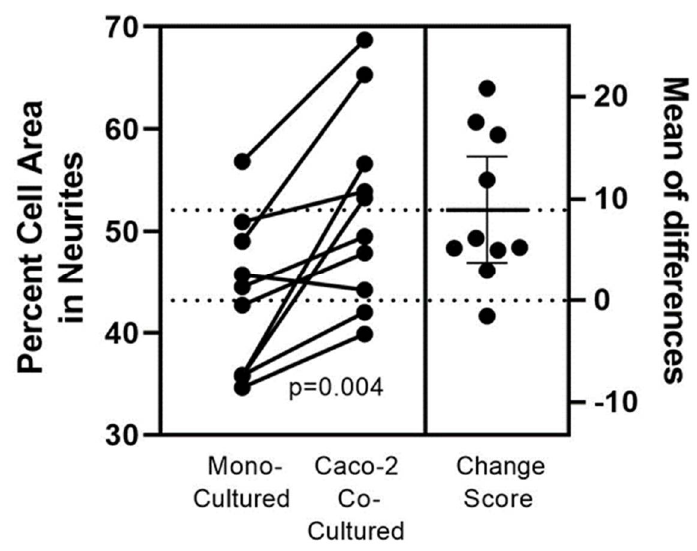
Figure 2. Quantifying the Caco2Bbe1 effect on neurite out-growth in SH-SY5Y cells directly co-cultured. Caco2Bbe1 (Caco-2) cells were plated at n = 200,000/well in 3 mL 6-well plates with complete 10% FBS media, incubated, and refed on day 6. On day 7 a single swipe was made in the middle of each well using flat end of a sterile p1000 pipette tip. Debris was removed and a fresh suspension of n = 2000 SH-SY5Y cells was added to each well along with fresh complete media (3 mL per well). Paired controls were set-up with SH-SY5Y cells in monocultures. Following 6 more days as co-cultures, media was removed, and the attached cells were stained with crystal violet. More details of this set-up may be found in Figure S1. Photographs were made at 40× magnification and SH-SY5Y cells were traced using ImageJ software. At least 5 neurons in each swiped area were chosen for tracing based on finding enough neurons that did not clump or overlap with other cells. The left Y-axis is the neurite percent of total cell volume. The number of neurites per cell was also tabulated but not shown (described in the text). Each dot represents average values from 3 wells per experi- mental condition (so at least 15 neurons were drawn per dot). Connected pairs of dots correspond to paired groups in each experiment. The p -value derives from a paired two-tailed t -test using all ( n = 10) experiments. The right Y-axis shows mean percent differences between each pair.